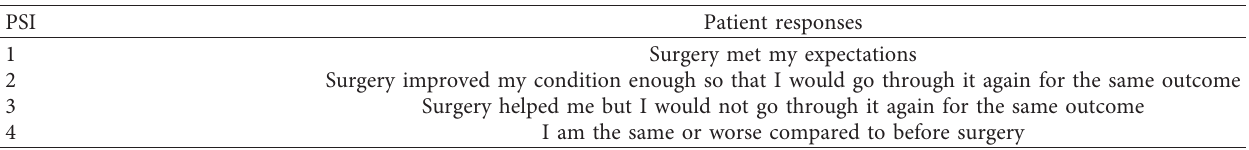
Figure 2: The shape on the sagittal MRI of TOLF. Sagittal T2-weighted MR images demonstrating morphological classifications of TOLF: (a) beak type and (b) round Table 1: Patient Satisfaction Index (PSI).